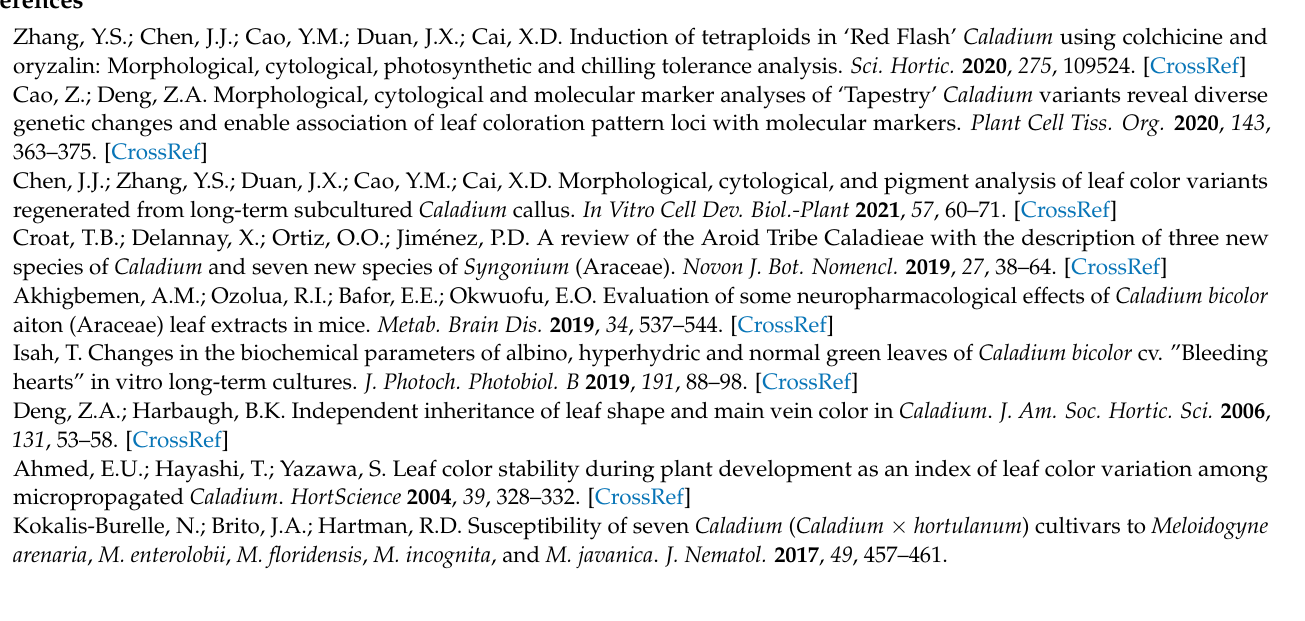
Table S3: Determination of optimal codons in the chloroplast genomes of Caladium; Table S4: The ENC values of the coding genes in the cp genomes of nie species of Araceae; Table S5: The GC